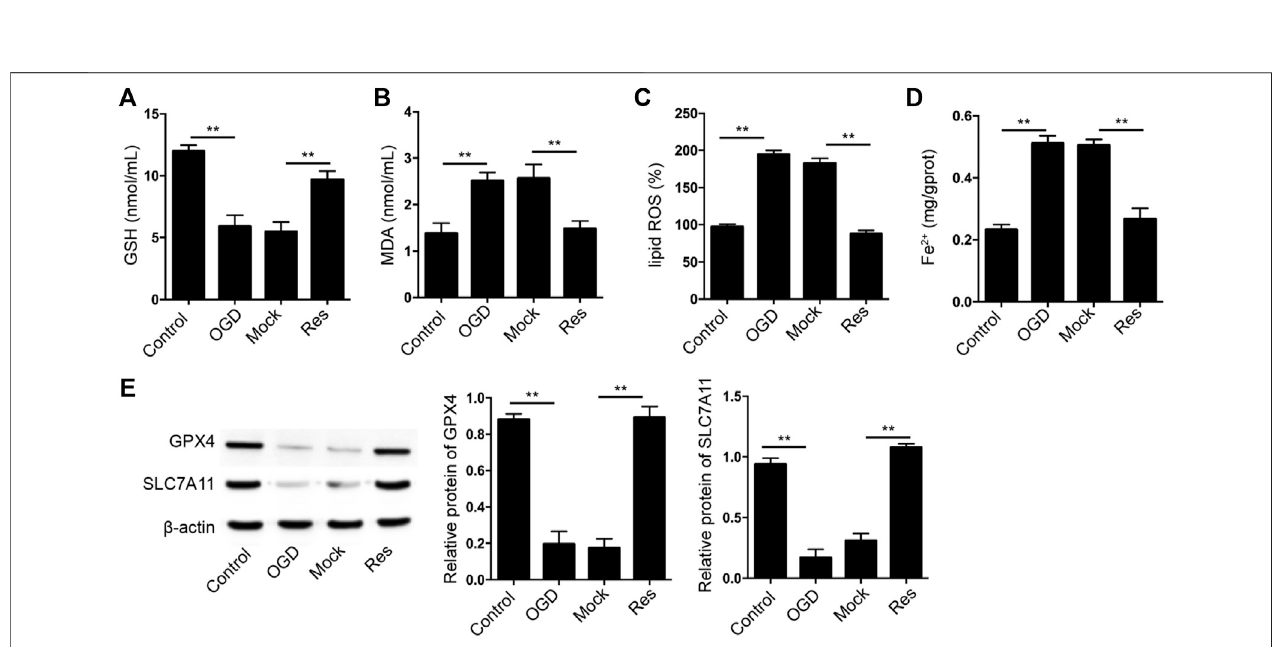
FIGURE 4 | Res represses OGD-induced cardiomyocyte ferroptosis . (A – E) The OGD-treated H9c2 cells were treated with Res. The levels of GSH (A) , MDA (B) , lipid ROS (C) ,and Fe 2+ (D) wereanalyzed. (E) Theexpression ofGPX4and SLC7A11wasdetected by Westernblotanalysisand was normalized on theexpression of β -actin. Data are presented as mean ± SD. Statistic signi fi cant differences were indicated: ** p < 0.01.